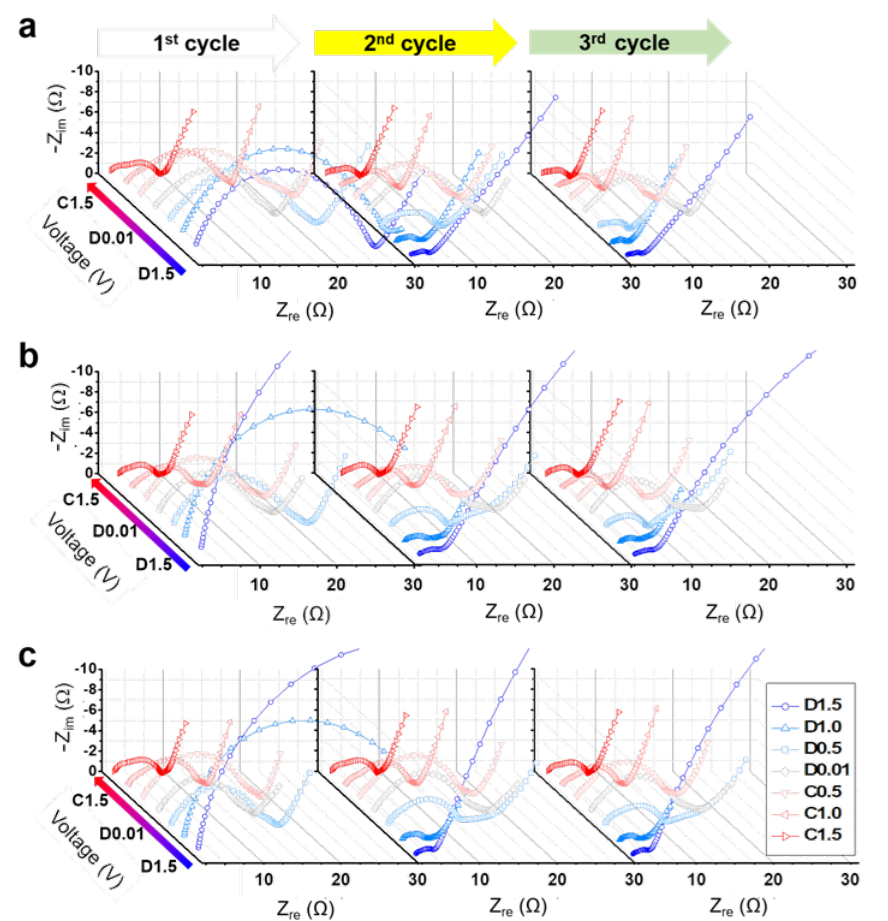
Figure 4. Nyquist plots of α -Fe 2 O 3 nanofibers at various voltages from D1.5 to C1.5: the α -Fe 2 O 3 nanofibers were annealed at ( a ) 300 °C, ( b ) 500 °C, and ( c ) 700 °C.